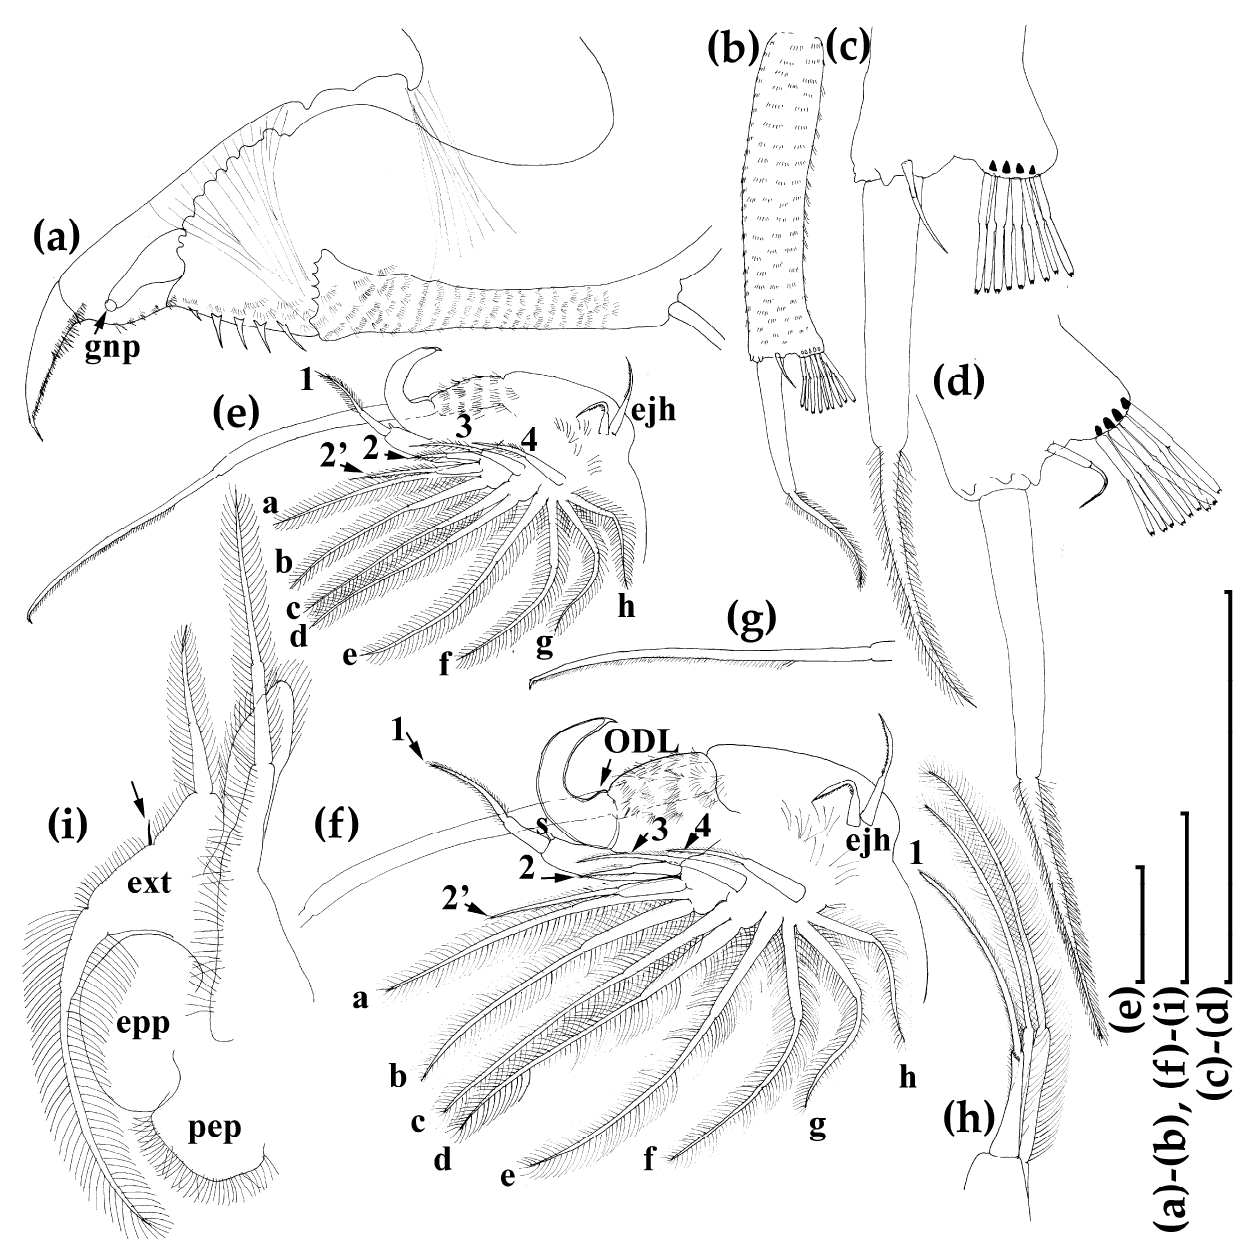
Figure 10. Daphnia arabica sp. nov., an adult male from Al Shuwaib Dam, near Al Ain city, United Arab Emirates. ( a ) Postabdomen. ( b ) Antenna I. ( c , d ) Distal portions of antenna I. ( e ) Thoracic limb I. ( f , g ) Fragments of thoracic limb I on higher magnification. ( h ) Fragment of thoracic limb II on higher magnification. ( i ) Thoracic limb V. All scale bars are 0.1 mm.